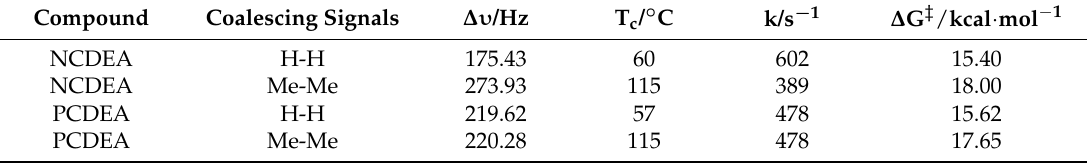
Table 2. Bond rotation in N , N -diethylamide derivatives measured by 1 H VT-NMR.